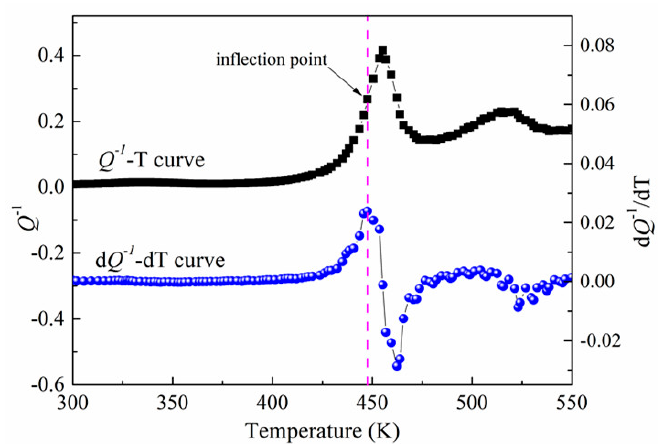
Figure 5. The Q − 1 -T curve and d Q − 1 /d T - T curve of (La 0.5 Ce 0.5 ) 65 Al 10 Co 25 BMG with a frequency of 0.5 Hz.